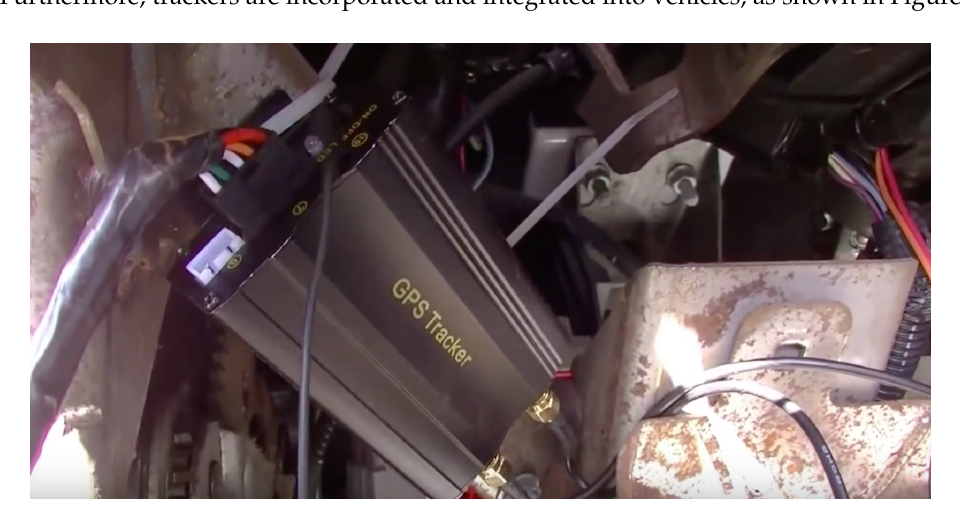
Figure 1. GPS tracker connection into one of our